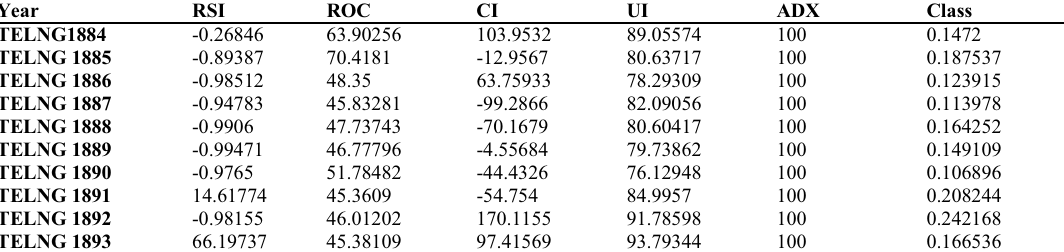
Table 2. Sample results after converting data with feature indicators (dataset2)